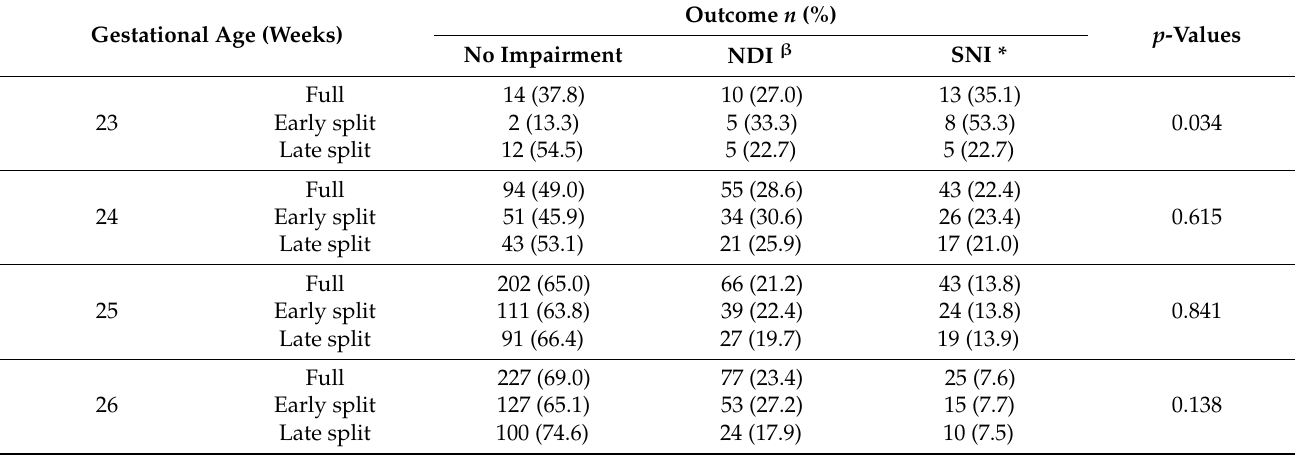
Table 4. Primary